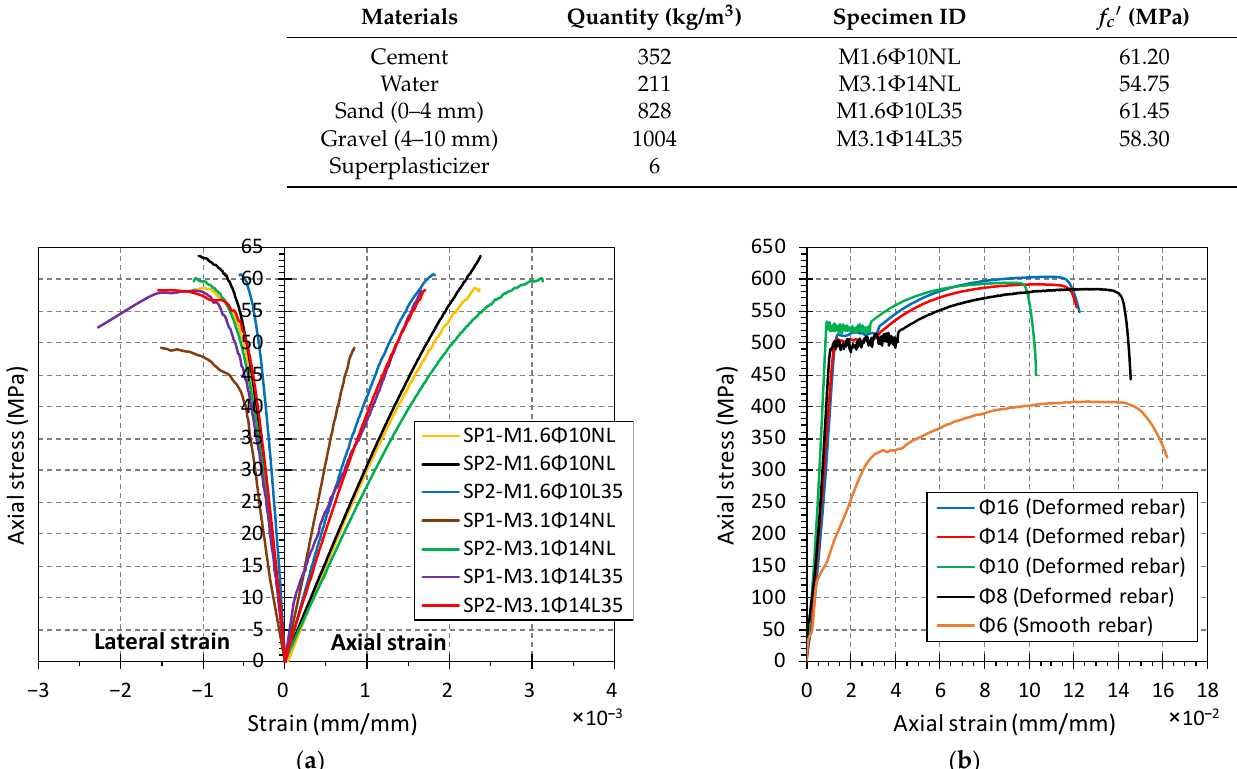
Figure 5. ( a ) Cylinder’s compression stress vs. lateral and axial strain curves for normal concrete; ( b ) Steel reinforcement tensile stress–strain